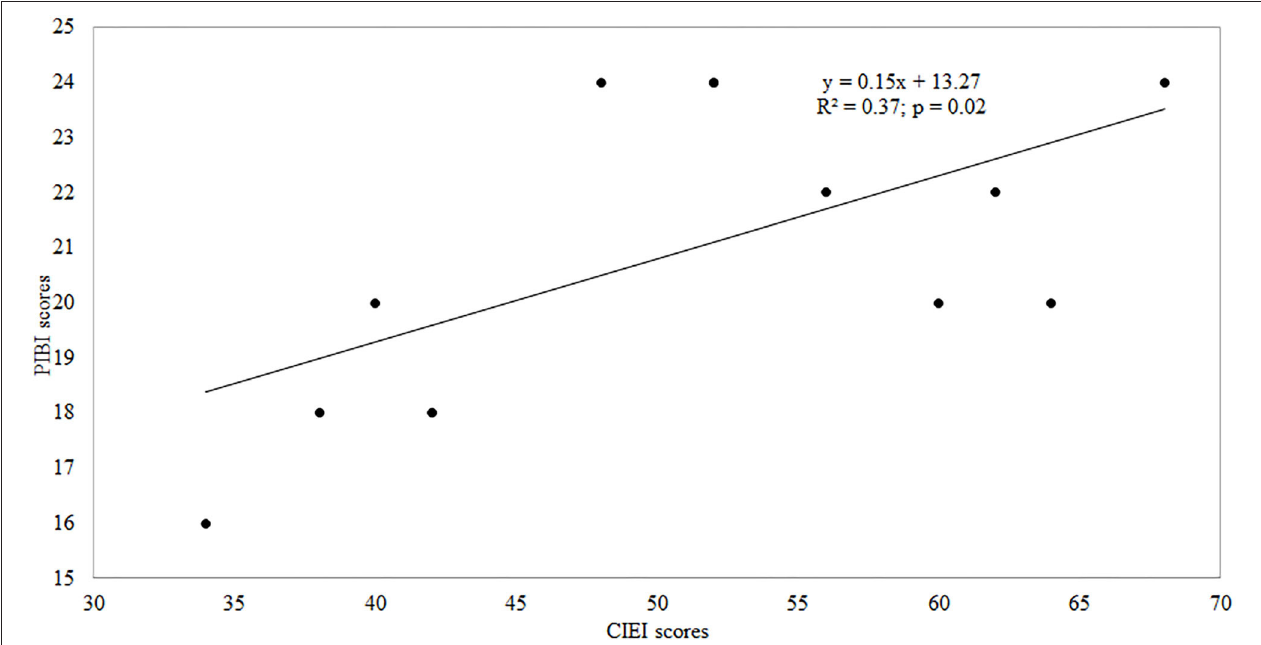
FIGURE 4 | A correlation plot showing the validation of the Citizen Index of Ecological Integrity (CIEI) novelty performance using previously developed Phytoplankton Index of Biotic Integrity